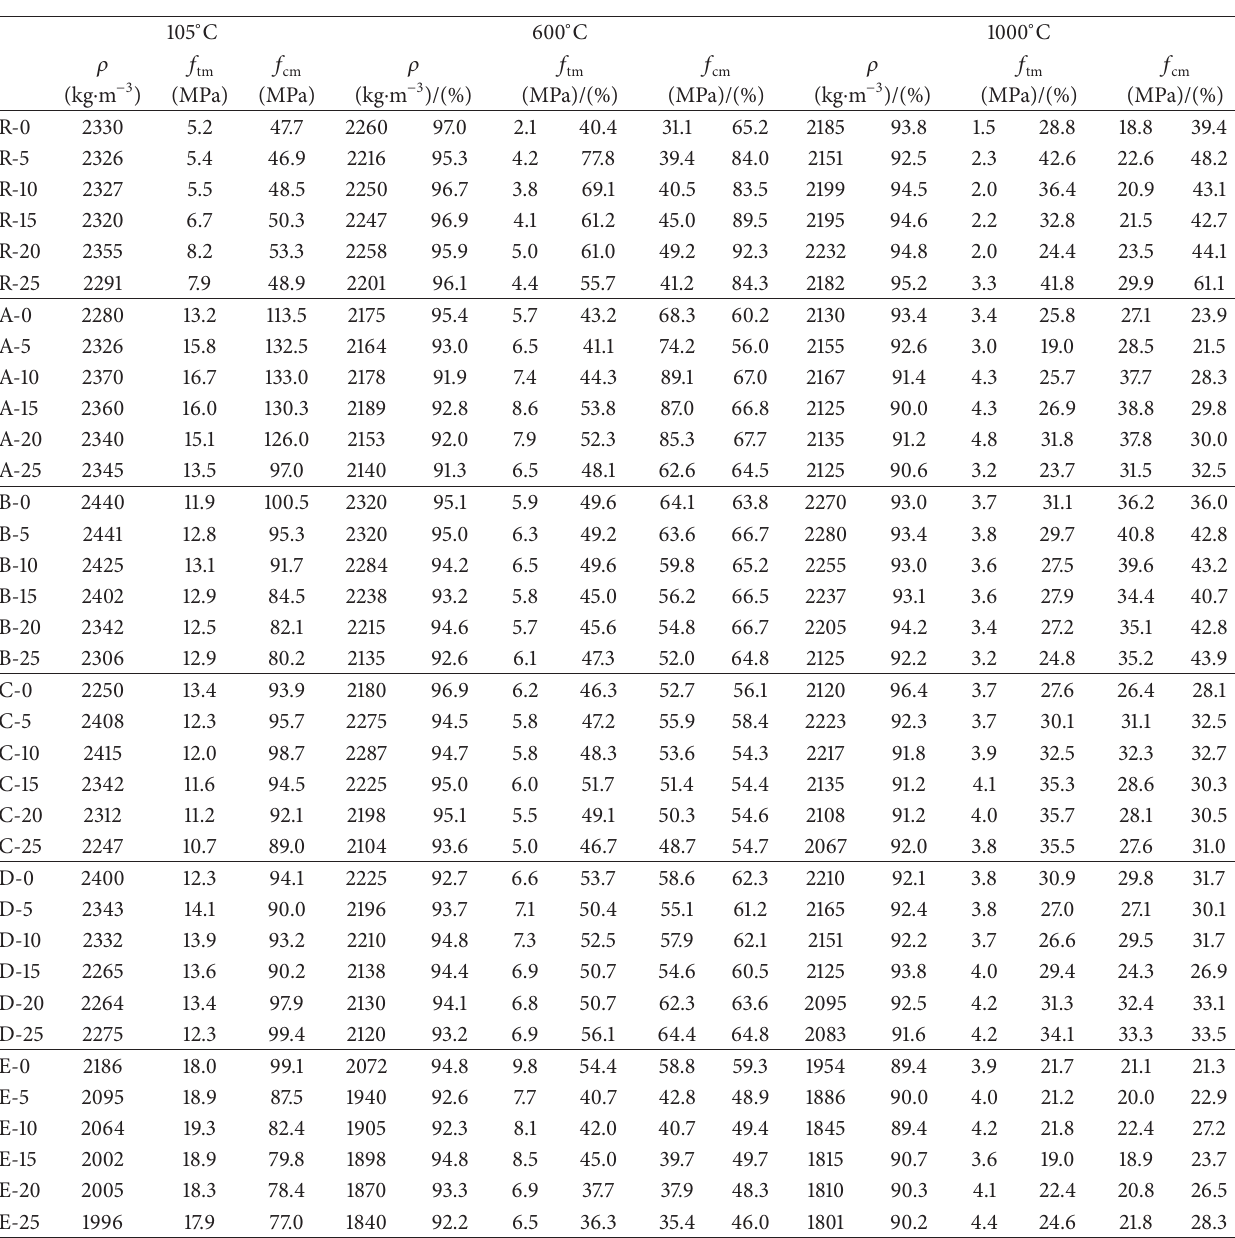
Table 3: Results of basic mechanical parameters